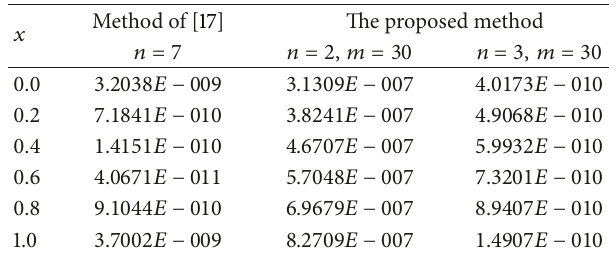
Table 1: Numerical comparison of absolute difference errors for Example